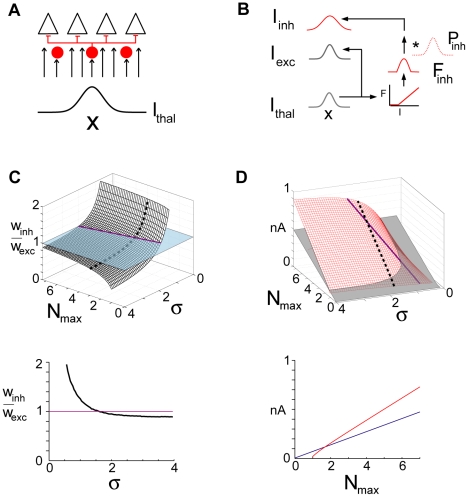
Activity in the feedforward network. A, Schematic of network architecture. Inhibitory cells innervate excitatory cells; both receive spatially distributed inputs (Ithal) from a presynaptic population of cells. B, Procedure for calculating spatial profiles of excitatory (Iexc) and inhibitory (Iinh) inputs to excitatory cells. C, top, ratio of Iinh to Iexc widths, winh/wexc, as a function of Nmax and σ. Nmax is normalized (divided) by the minimum current needed to evoke excitatory cell firing and σ is normalized by the standard deviation of the inhibitory spread (σinh of Pinh in B). Intersection with unitary plane (purple) gives values of Nmax and σ where Iexc and Iinh are perfectly co-tuned. Bottom, plot of winh/wexc vs σ at Nmax = 3 (corresponding to dotted line at Top). D, Peak excitatory (gray) and inhibitory (red) current plotted against Nmax and σ. Purple line corresponds to values of Nmax and σ that produced perfect co-tuning in C. Bottom, plot of peak excitatory (blue) and inhibitory (red) vs Nmax for σ = 1.6 (corresponding to dotted line at top).